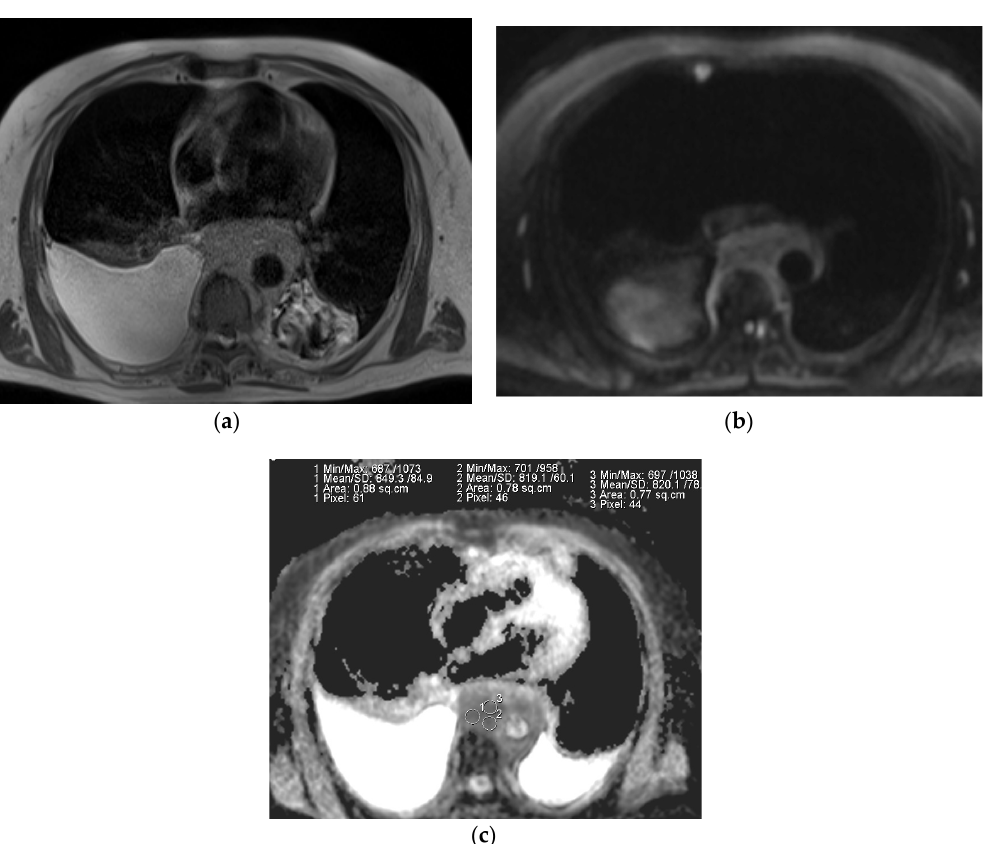
Table 2. ADC mean values of lymph nodes from different etiologies .